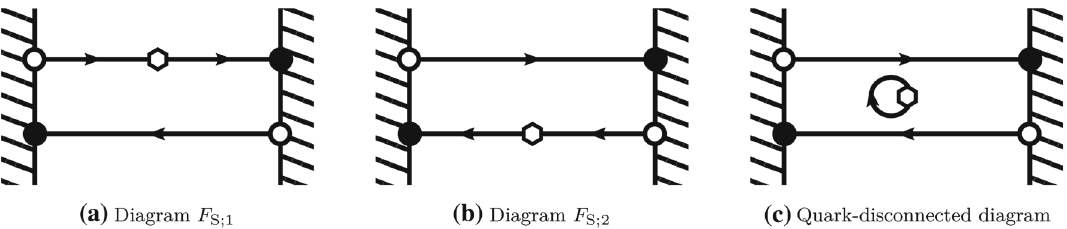
circles denote ¯ ζ (at x 0 = 0) and ¯ ζ (cid:12) (at x 0 = T ). Quark-connected dia- grams F S ; 1 and F S ; 2 are single traces, formed by starting from any point and following the lines (quark propagators) around until we close the